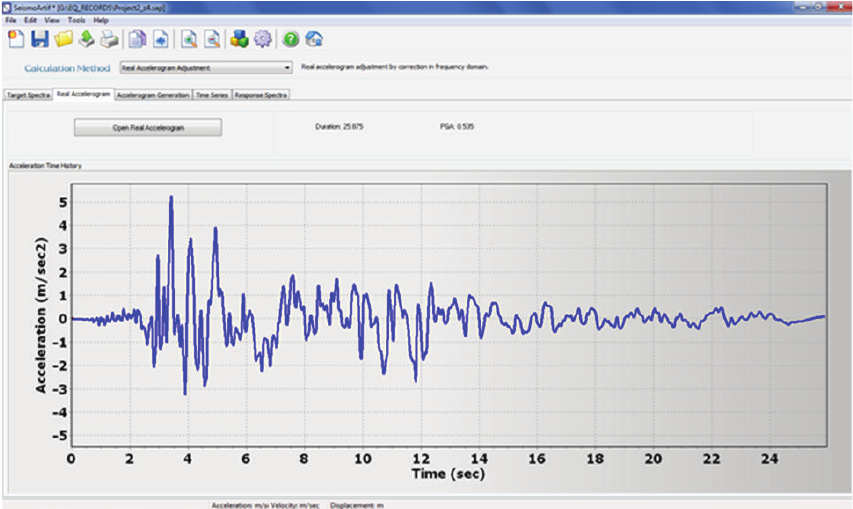
Figure 6: Real accelerogram recorded during Duzce 99 earthquake at Duzce Station